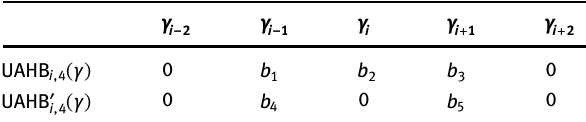
Table 2: The values of UAH tension B - spline of order 4, i.e. , ( ) γ UAHB i ,4